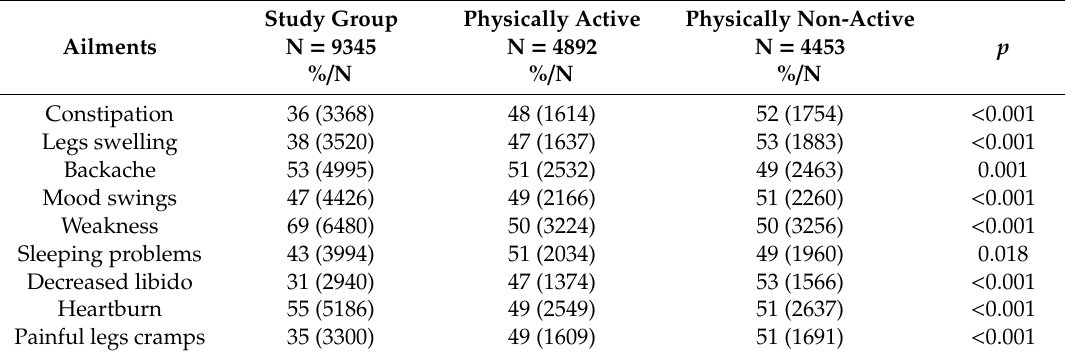
Table 2. Pregnancy ailments in the study group.